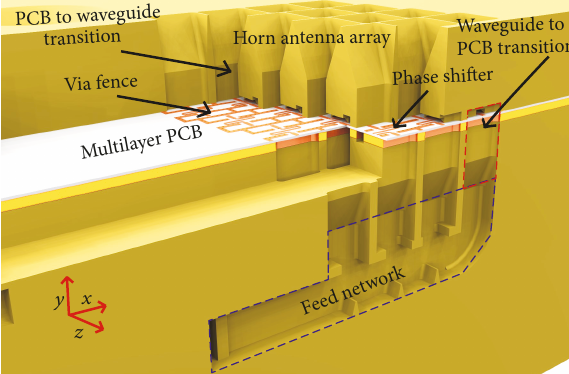
Figure 2: 3D model cutaway picture of the proposed phased antenna array.